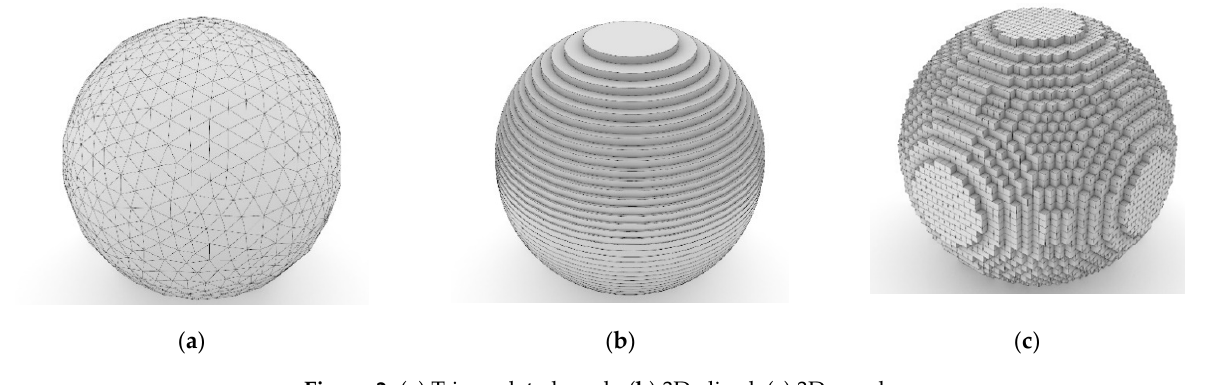
Figure 2. ( a ) Triangulated mesh, ( b ) 3D-sliced, ( c ) 3D voxels.